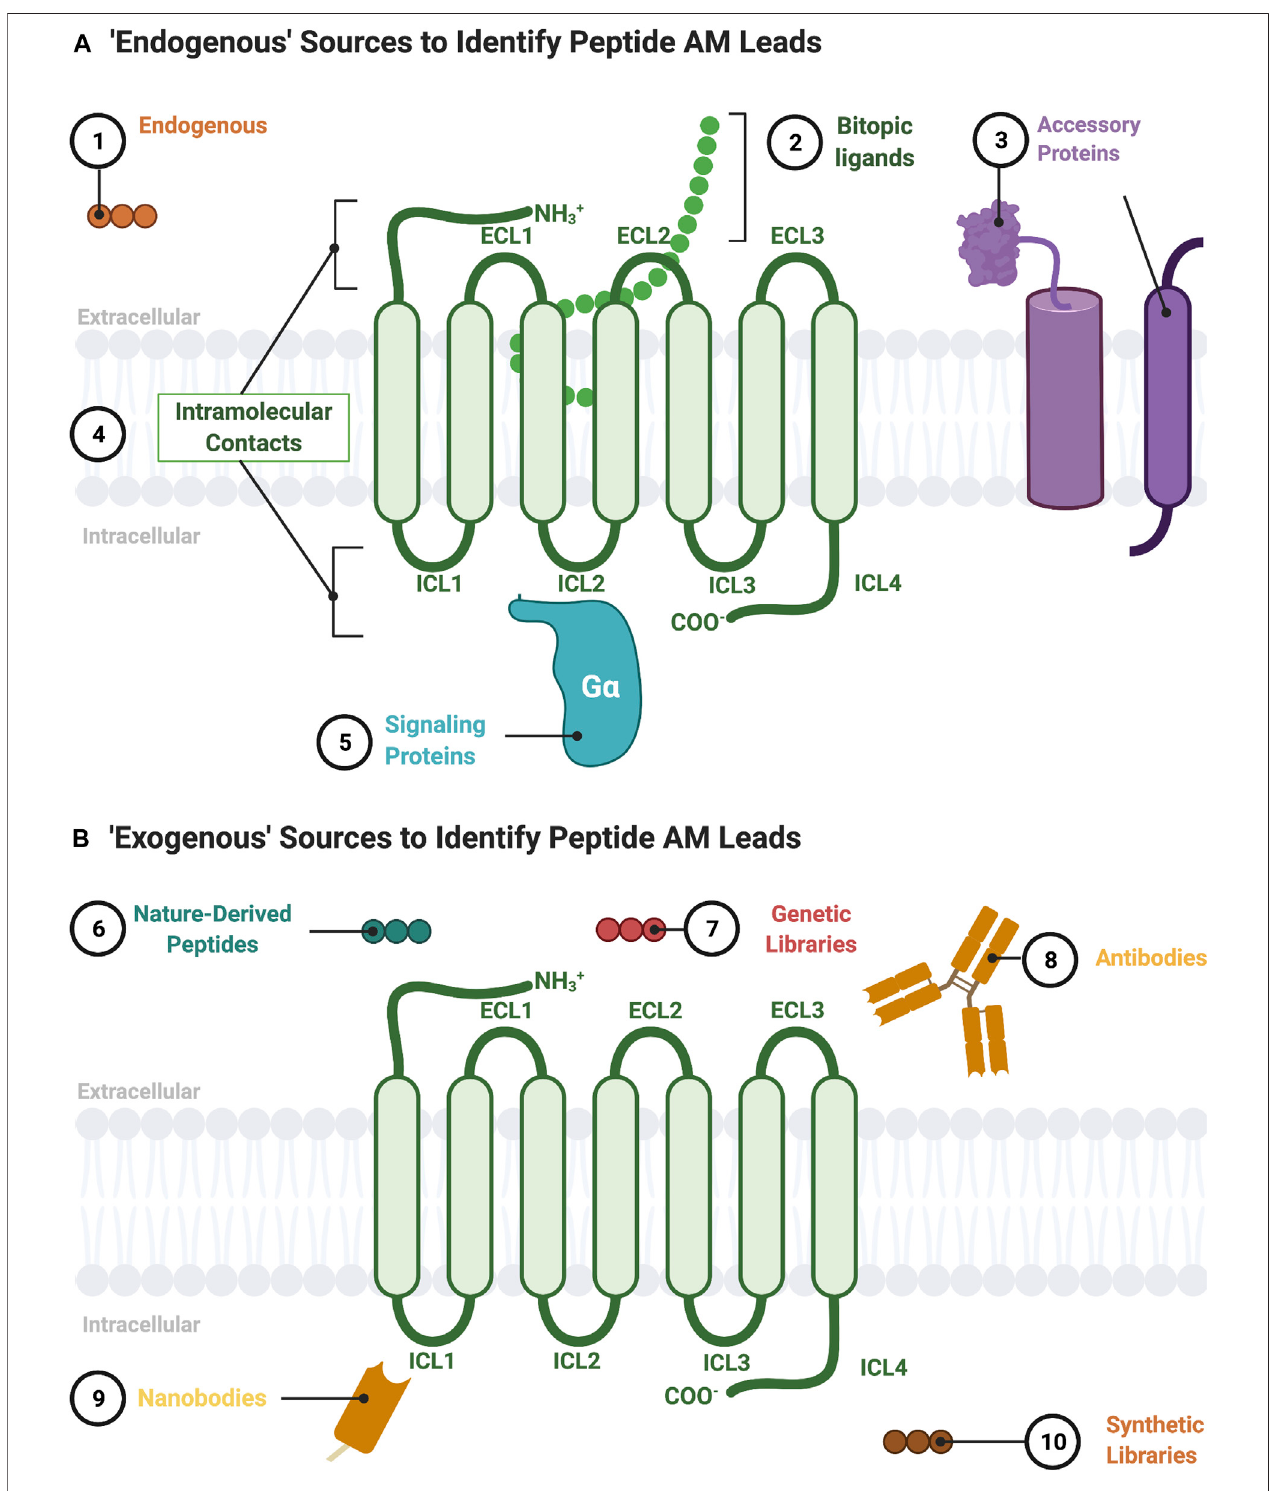
FIGURE 2 | Sources to identify peptide AM leads. (A) “ Endogenous ” sources of peptide AMs include the following: 1) endogenous peptide sequences such as orthostericligandsfromotherreceptorsorproteinfragments;2)nonorthostericsiteresiduesfromlarge endogenous bitopicpeptidesorhormones;3)accessoryprotein protein-protein interactions, such as RAMPs, heterooligomers, and RTKs; 4) intramolecular contacts, such as sequences from the ICL (pepducins) or ECL regions; 5) signaling protein protein-protein interactions, such as G α . (B) “ Exogenous ” sources for peptide AMs include 6) nature-derived peptides, such as from natural product libraries, conotoxins, cyclotides, and snake/scorpion venom; 7) genetic libraries, such as phage-display or directed evolution platforms; 8) antibodies including engineered and autoantibodies; 9) nanobodies; 10) synthetic libraries, such as combinatorial or DNA-encoded libraries. Figure was created with BioRender.com 1 .